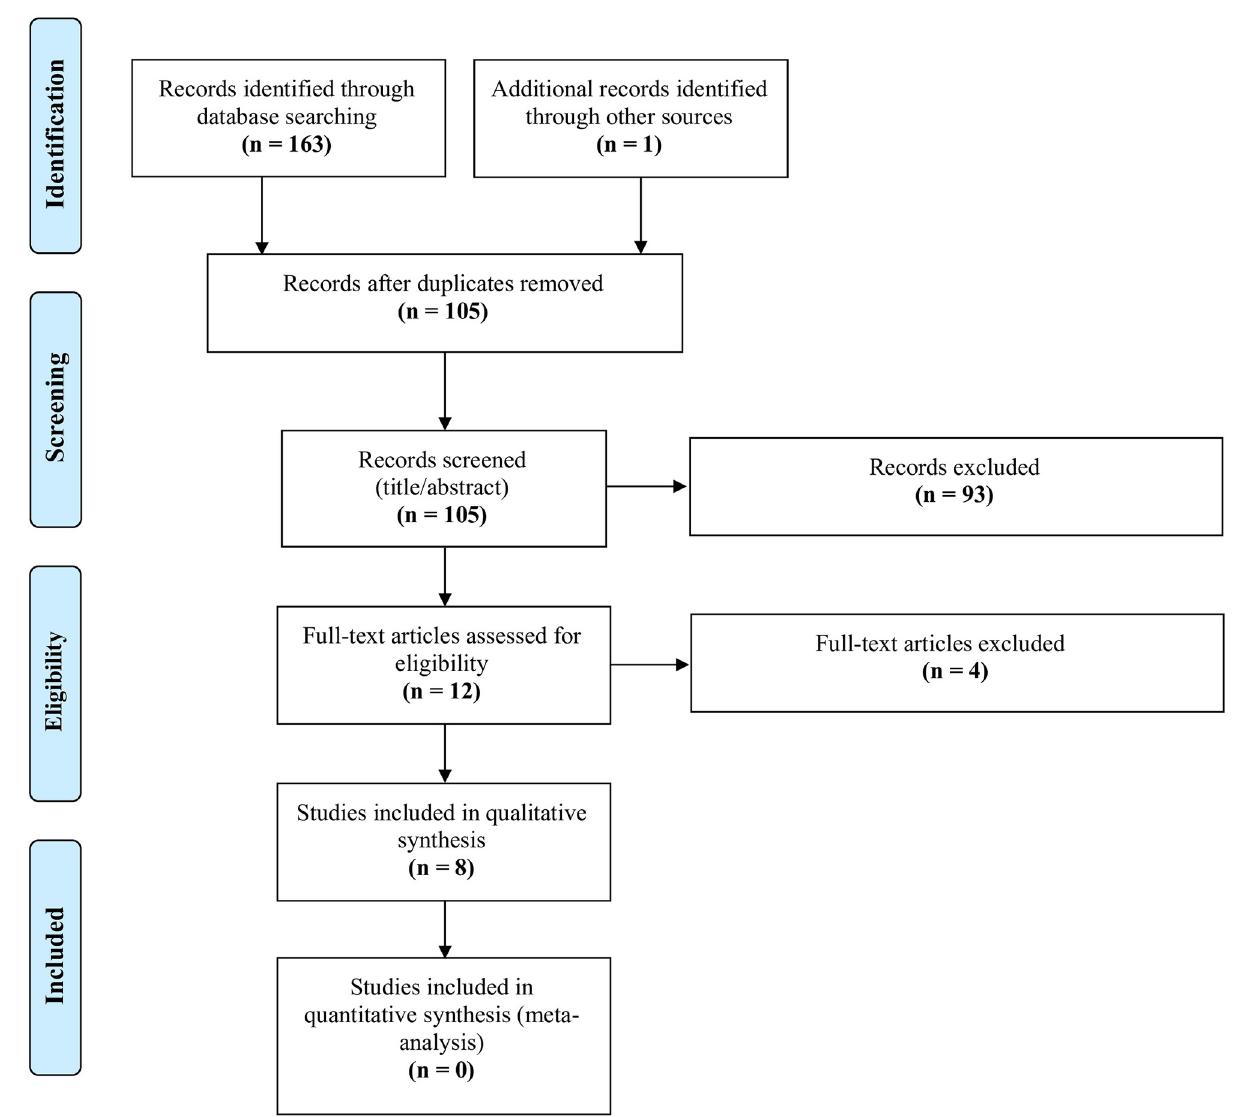
Fig 1. PRISMA flow diagram showing the inclusion and exclusion of